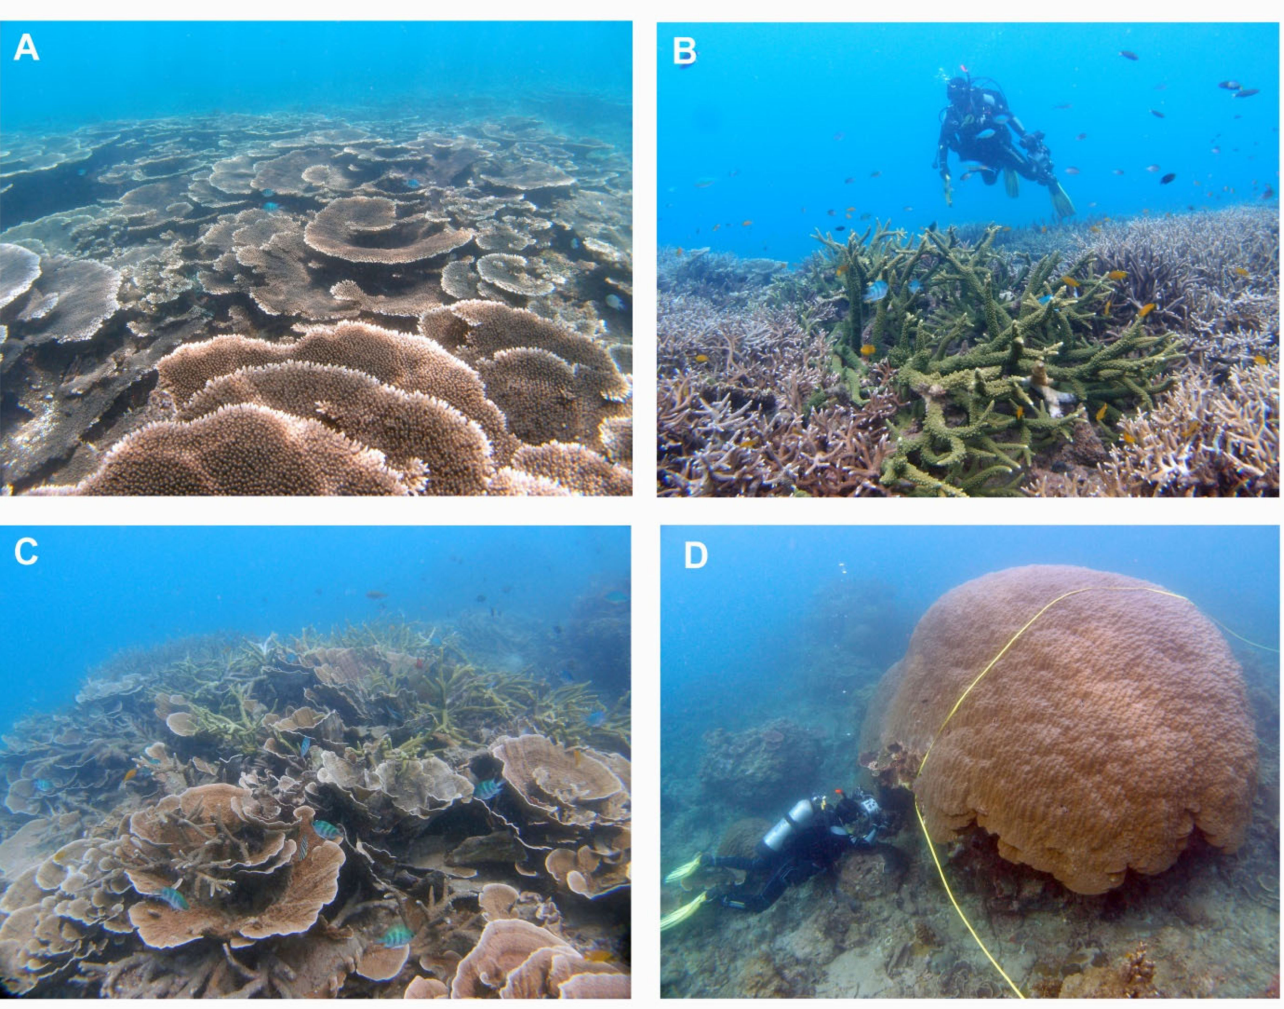
Figure 4. Dominant coral communities in the water area of Con Dao National Park. ( A ): multi-tiered stands of table Acropora (mostly A. hyacinthus and A. cytherea ) in the upper reef slopes (2–5 m depth, sites 1–6); ( B ): branching Acropora (mostly A. intermedia , A. muricata , A. grandis and A. robusta ) in the upper and middle reef slopes (3–7 m depth, sites 1–6); ( C ): assemblages of foliaceous Montipora (mostly M. aequituberculata and M. hispida ) together with branching Acropora in the middle reef slopes (4–8 m depth, sites 1, 2, 4 and 6); ( D ): large heads of massive Porites (mostly P. lobata and P. lutea ) in the lower reef slopes (7–12 m depth, sites 1, 4 and 6). (Photos taken by K.S.